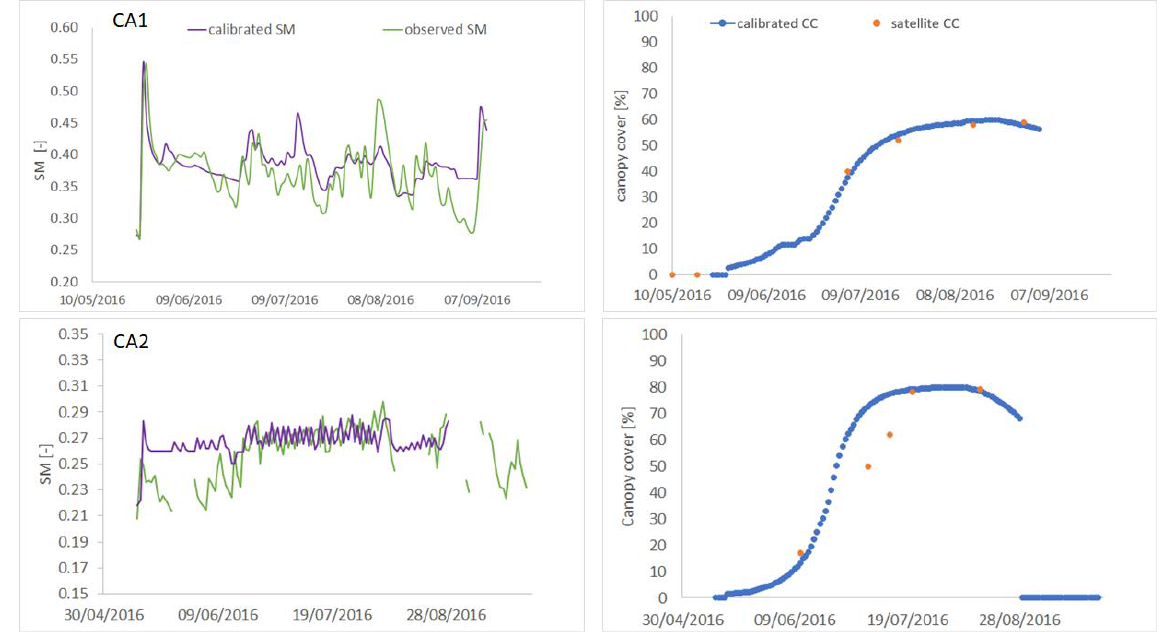
Figure 3. Model calibration for Capitanata fields against ground-observed soil moisture and satellite canopy cover for the first field (CA1) and second field (CA2). Table 4. Statistical indices results for model calibration in the Capitanata Irrigation Consortium.